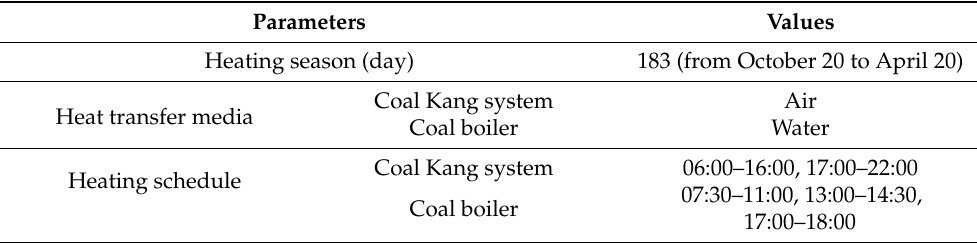
Table 2. Intermittent heating